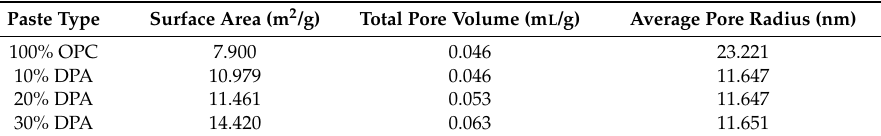
Table 4. Total pore volume, surface area, and average pore radius of paste mixtures at 28 days.